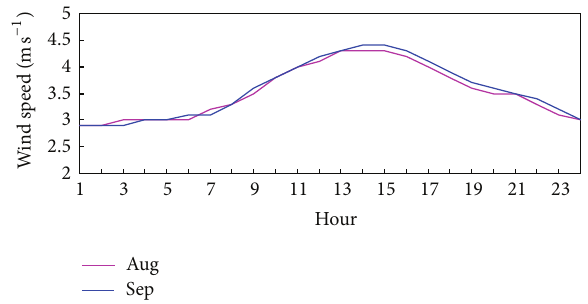
Figure 3: Time series of wind speed in August and September for Qingdao based on data of